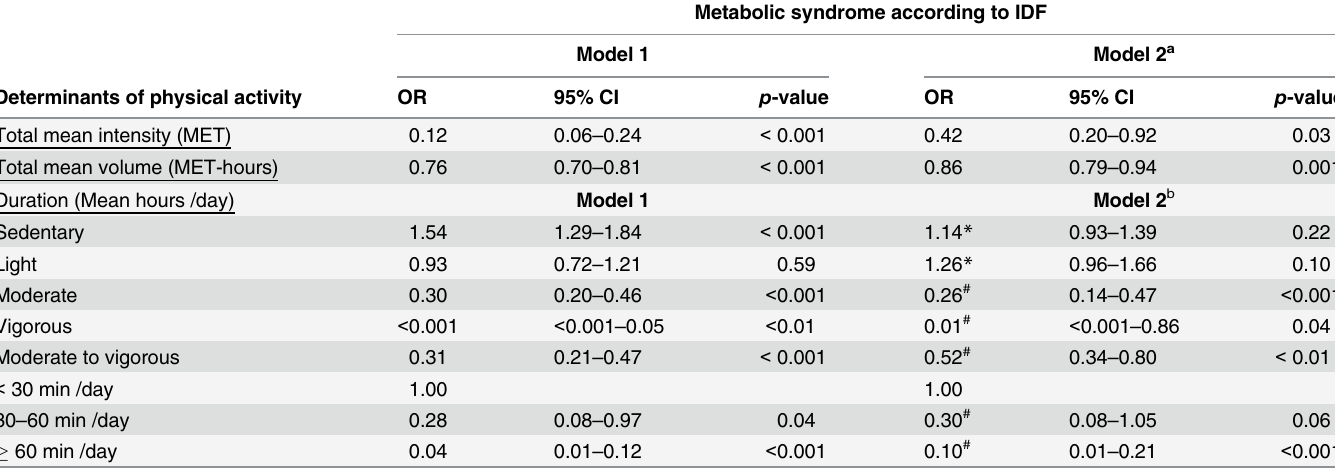
Table 4. ORs and 95% CIs for MS according to IDF criteria by intensity, volume and duration of physical